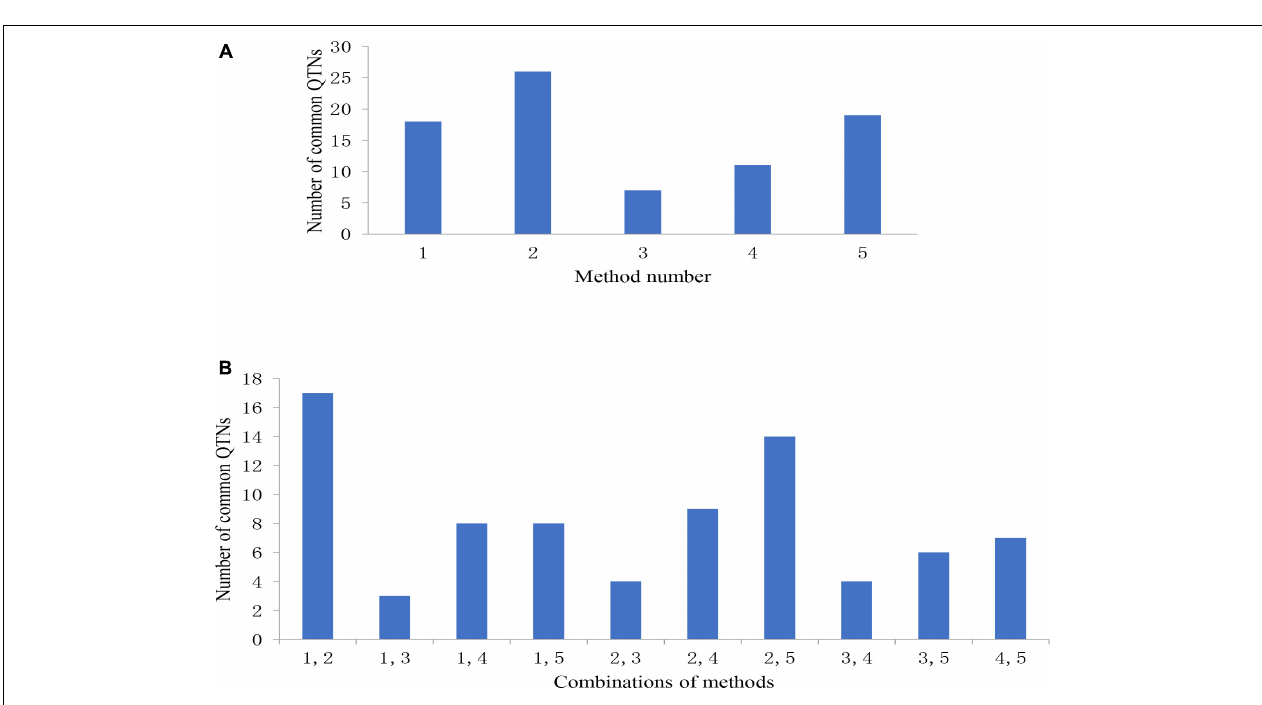
FIGURE 4 | (A) The number of common QTNs detected by different methods and (B) different combinations of methods. Method numbers correspond to (1) mrMLM, (2) FASTmrMLM, (3) FASTmrEMMA, (4) pLARmEB, and (5) ISIS EM-BLASSO.